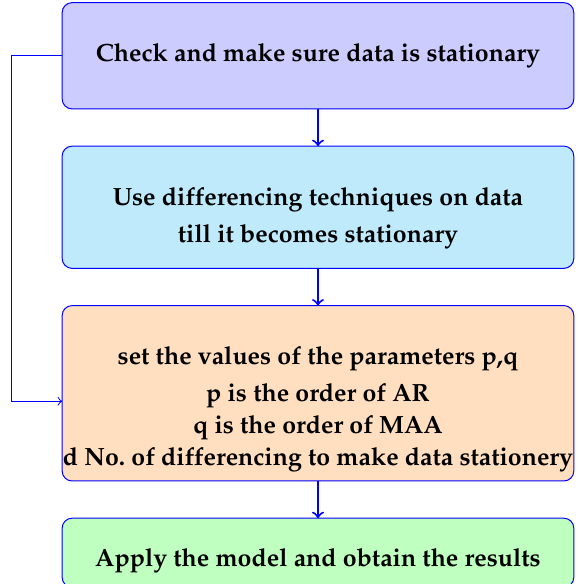
Figure 2. The workflow of the ARIMA